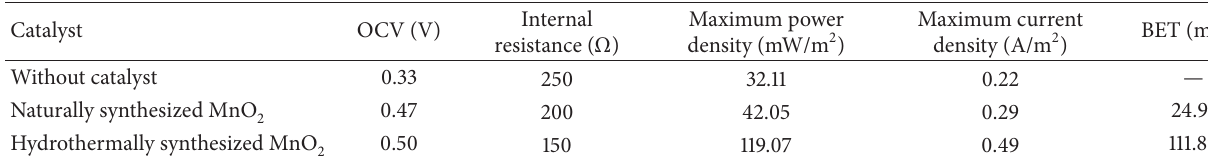
Table 1: Performance of MFCs based on different cathodic catalysts.